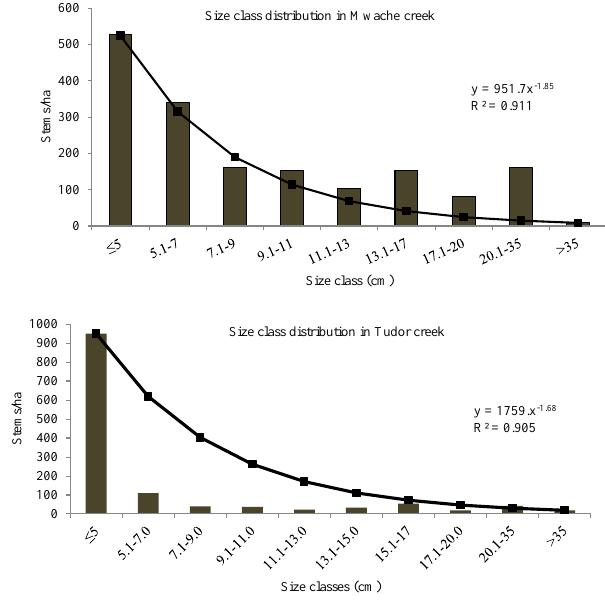
Figure 3: Size class distribution 14 Fig. 3. Size class